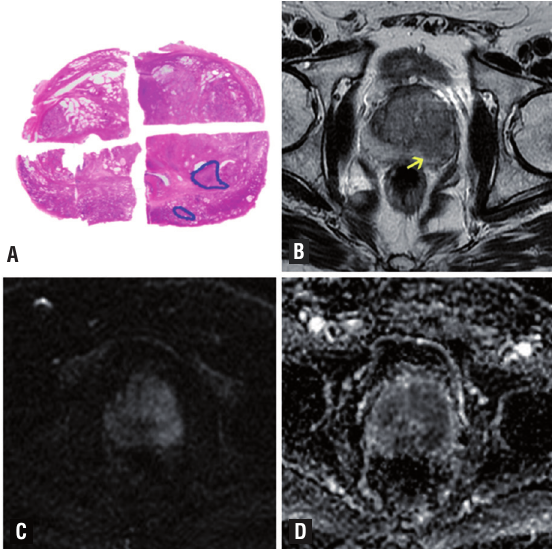
Figure 2 - Male, 61-year-old patient with prostate cancer Gleason 7 (4+3) with ECE. (a) RP specimen shows index lesion of 30 mm on left base of the prostate. MRI demonstrates heterogeneous and high signal multinodular in T2w sequences (b), there is no hypervascular lesions and no focal areas of restriction on DWI (c) and ADC images (d). No extracapsular extension is seen on MRI. PIRADS score on MRI: T2WI = 2/5; DWI =